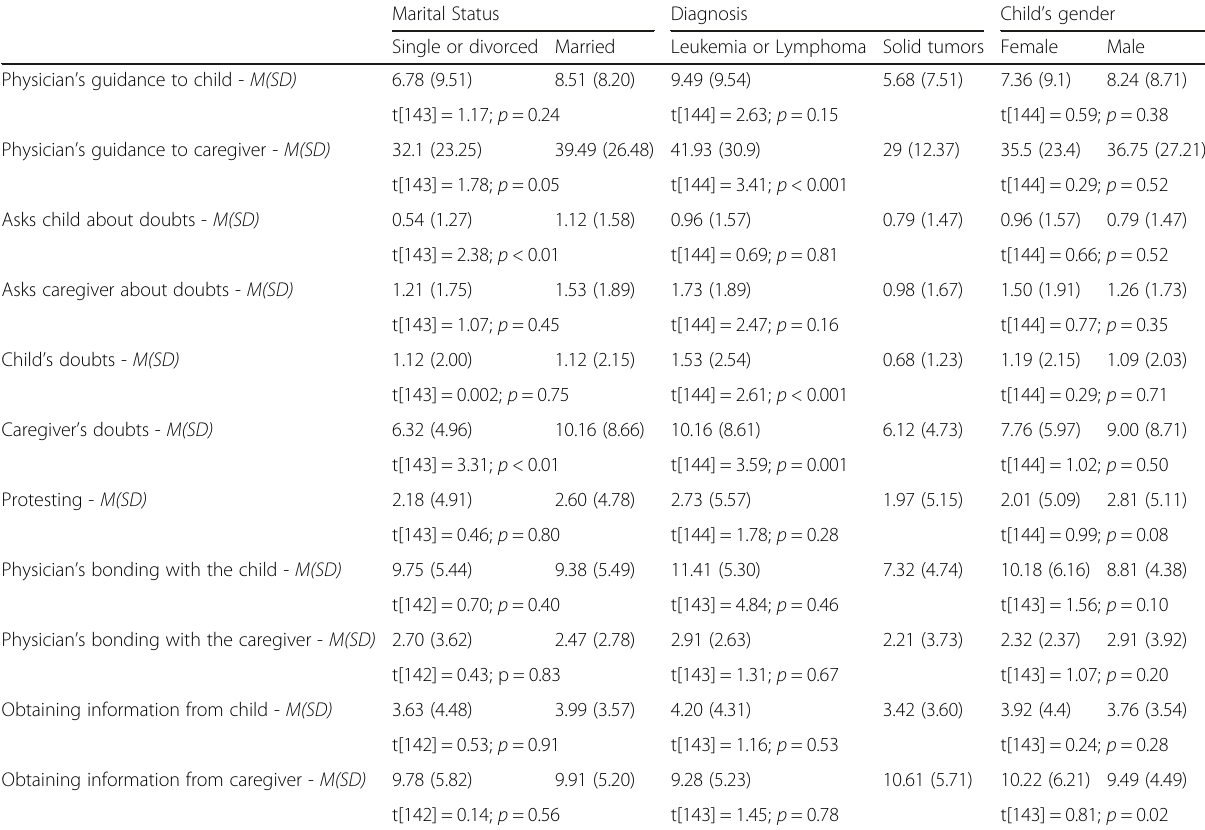
Table 4 Associations Between Physician ’ s Communicative Behaviors, Caregiver ’ s Marital Status, Diagnosis, and Child ’ s Gender Marital